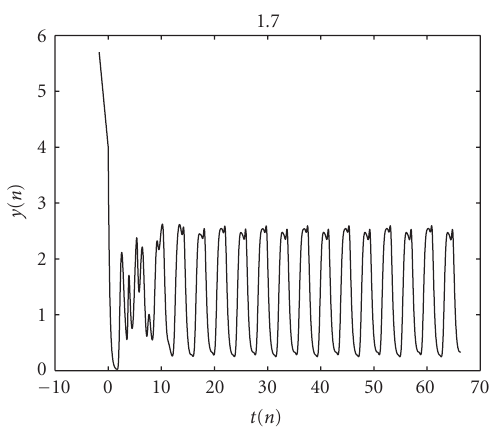
Figure 4.2. The equilibrium of (2.2) is unstable when τ = 1 .